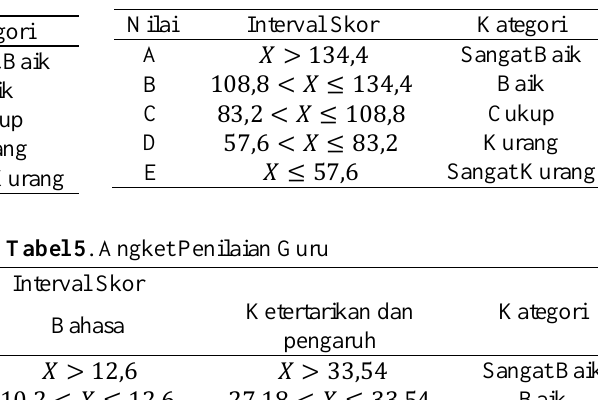
Tabel 4 . Kriteria Penialian Sikap Siswa Terhadap